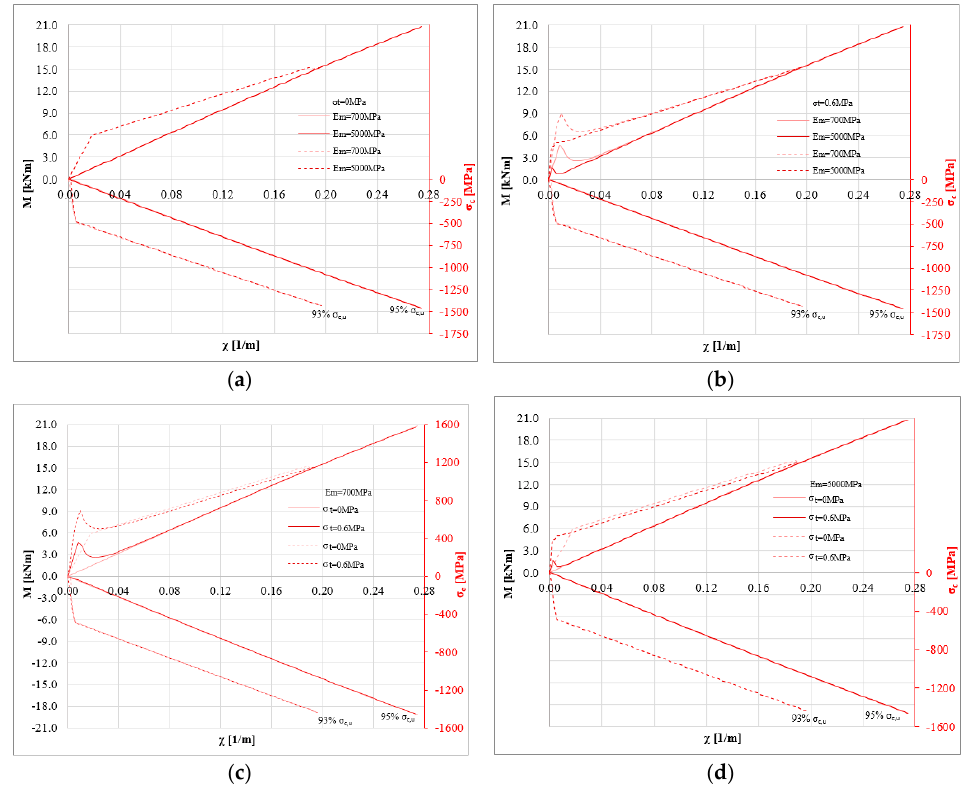
Figure 6. M- χ and σ c,u diagrams: P = 0 N, σ 0 = 8 MPa, σ t = 0 and 0.6 MPa, E m = 700 and 5000 MPa for linear (solid lines) and bi-linear (dotted lines) relationships for the strengthening system (basalt fiber): ( a ) σ 0 = 8 MPa, σ t = 0 MPa changing E m ( b ) σ 0 = 8 MPa, σ t = 0.6 MPa to changing E m ( c ) σ 0 = 8 MPa, E m = 700 MPa changing σ t ( d ) σ 0 = 8 MPa, E m = 5000 MPa changing σ t .